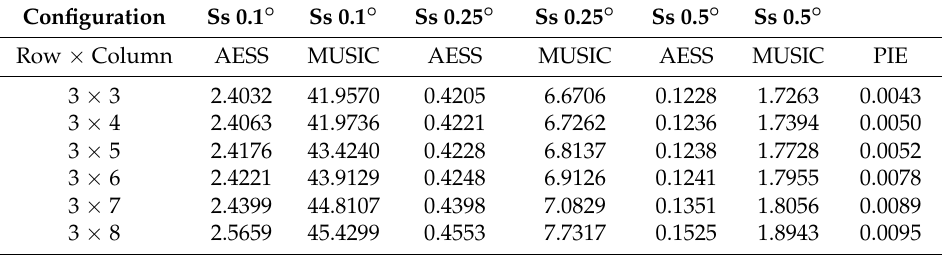
Table 1. Comparison of CPU time (s). Ss in the table means stepsize.